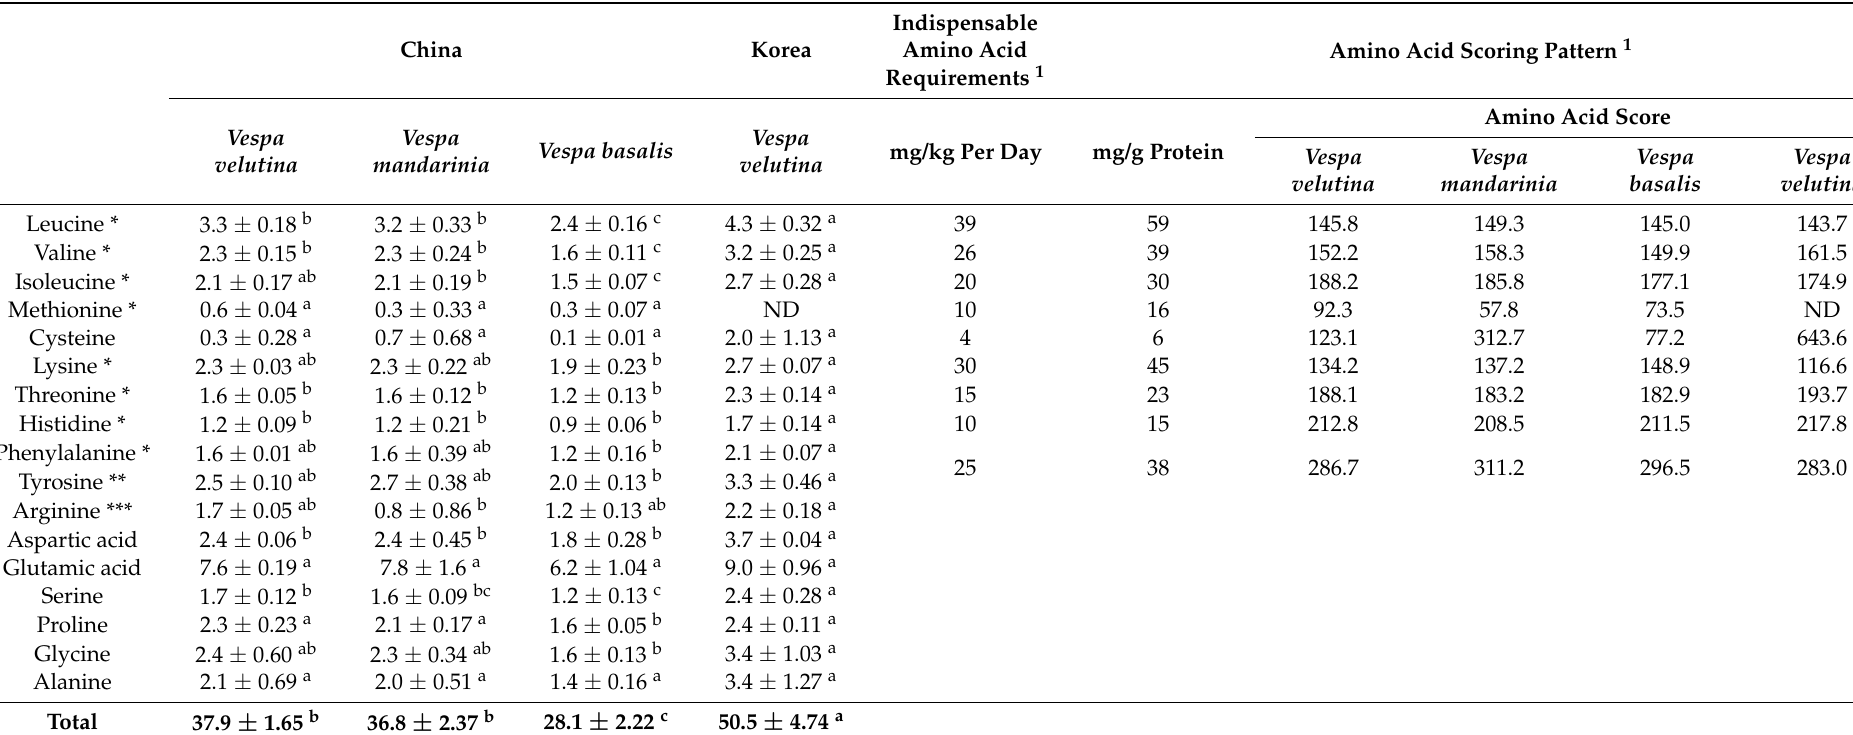
Table 1. Amino acid composition (g/100 g dry matter, mean ± SD, duplicate analysis with composite sampling process) of different Vespa species broods, requirement of indispensable amino acid and amino acid scoring pattern as per the WHO/FAO/UNU [26] and amino acid scoring pattern